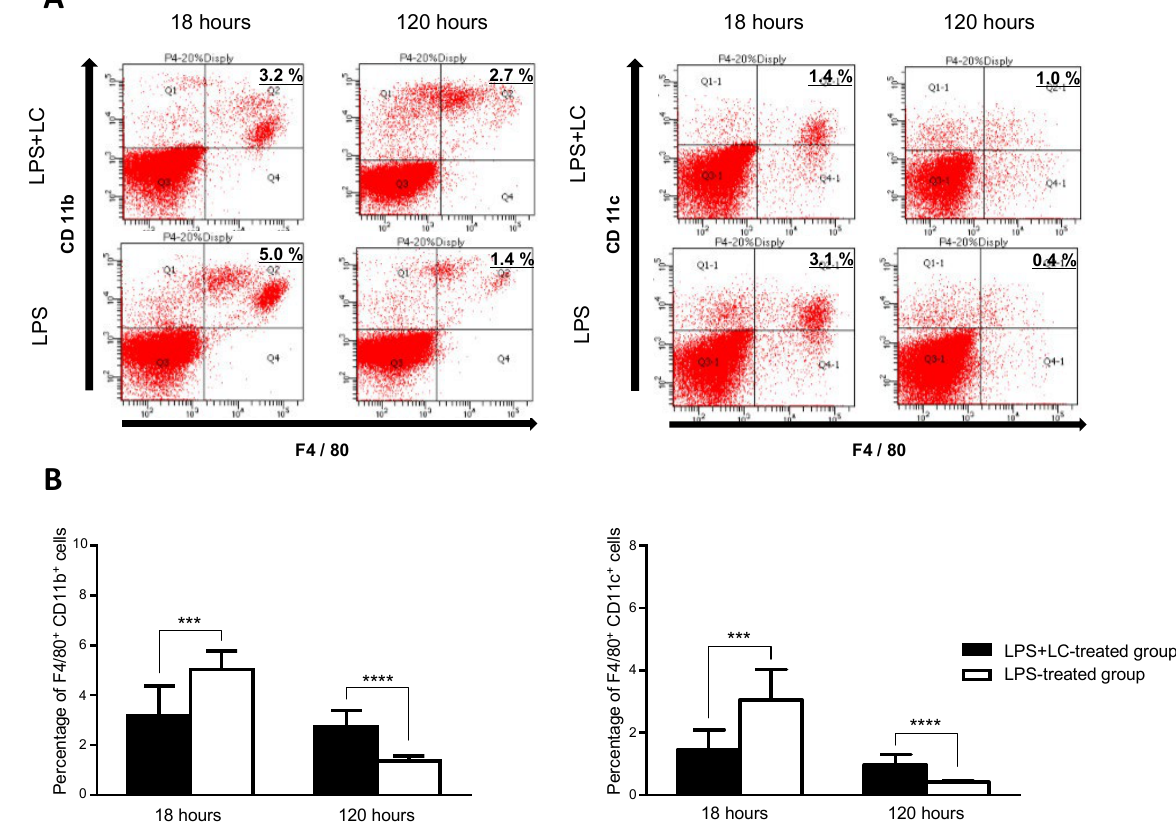
Figure 2. Liposomal clodronate depleted CD11b + and CD11c + cells gating with F4/80 + cells. ( A ): At 18 and 120 h after the LPS injection, cell suspensions were obtained from the kidney of LPS + LC-treated and LPS-treated mice ( n = 10 each). Representative data from the FACS analysis are shown. ( B ): The percentages of CD11b + F4/80 + and CD11c + F4/80 + cells. The data are mean ± SEM. *** p < 0.005, **** p < 0.001, LPS + LC vs. LPS-treated group.